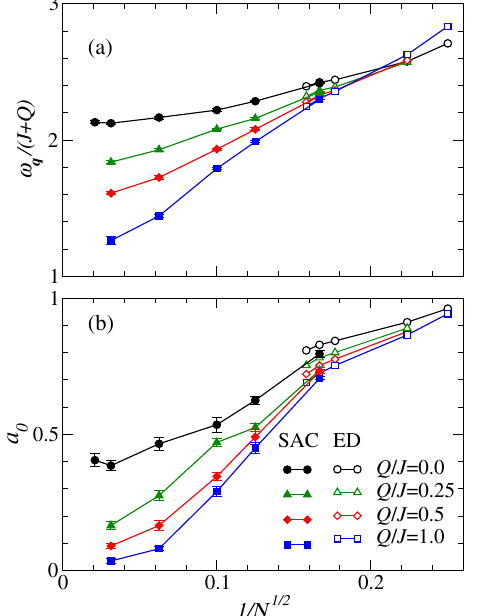
FIG. 14. Size dependence of the excitation energy ω q (a) and the relative weight of the magnon pole a 0 ð q Þ (b) at q ¼ ð π ; 0 Þ close to the Heisenberg limit of the J - Q model.